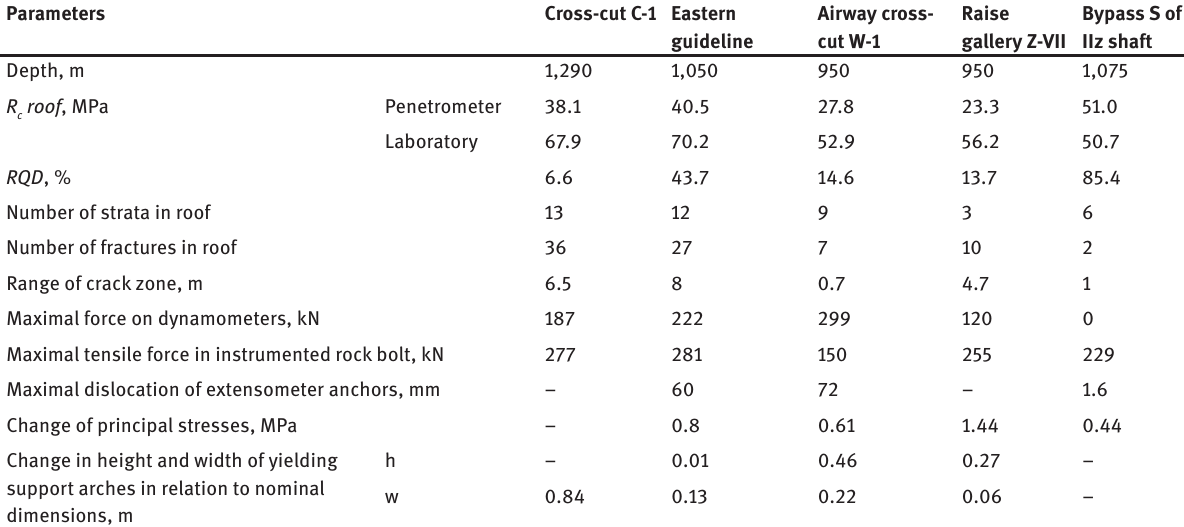
Table 1: Research results in monitored excavations. Parameters